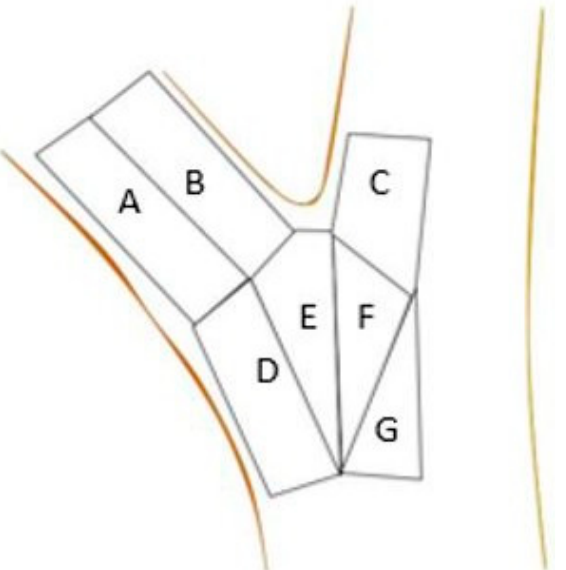
Figure 2. Example of the grid system ( A ) of test points used for post-processing measurement of and ( B ) example of the measurement of separation angle using DIC software on codominant red maple. Test points were grouped into one of seven zones (A–G, Figure 3). To compare unions with each other, the zones created were based on the branch’s anatomy. Zone A covered the branch’s bottom surface, immediately distal to the attachment. Zone B covered the branch’s top half (closer to the stem) with the same dimensions as zone 1. Zone C was defined as the area closest to the union extending upward on the stem to the edge of the area of interest. Zone C extended halfway into the stem (diameter) and ended at the top of the union. Zone D was the area immediately below zone 1 and encompassed the branch’s abaxial surface below the union. Zone D was composed of branch tissue in the upper portion and stem tissue in the lower portion and extended over half the branch diameter and down to the bottom of the area of interest. Zone E was immediately proximal to the union from Zone D and extended straight down from the union to the bottom of the area of interest and over to the midpoint of the branch. Zone F was the stem compliment to Zone E and extended half the diameter of the stem. Zone G was below Zone F and extended down to the bottom of the area of interest and halfway across the stem.